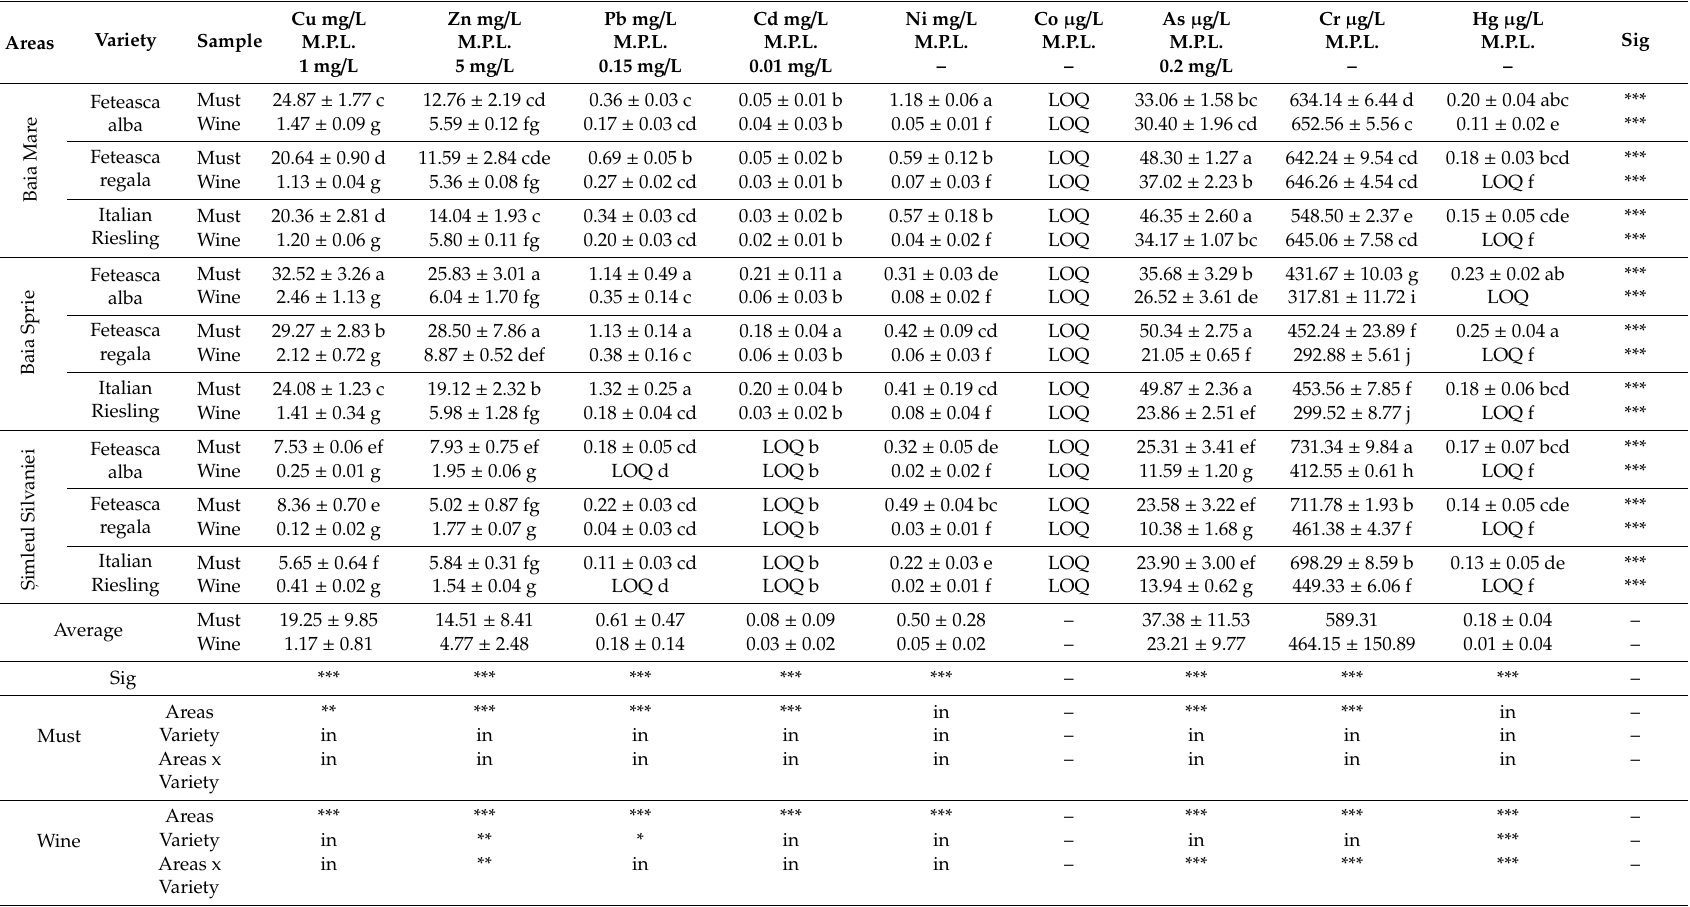
Table 3. The content of metal concentration in must and wine samples (Mean ± standard deviation) ( n = 3).